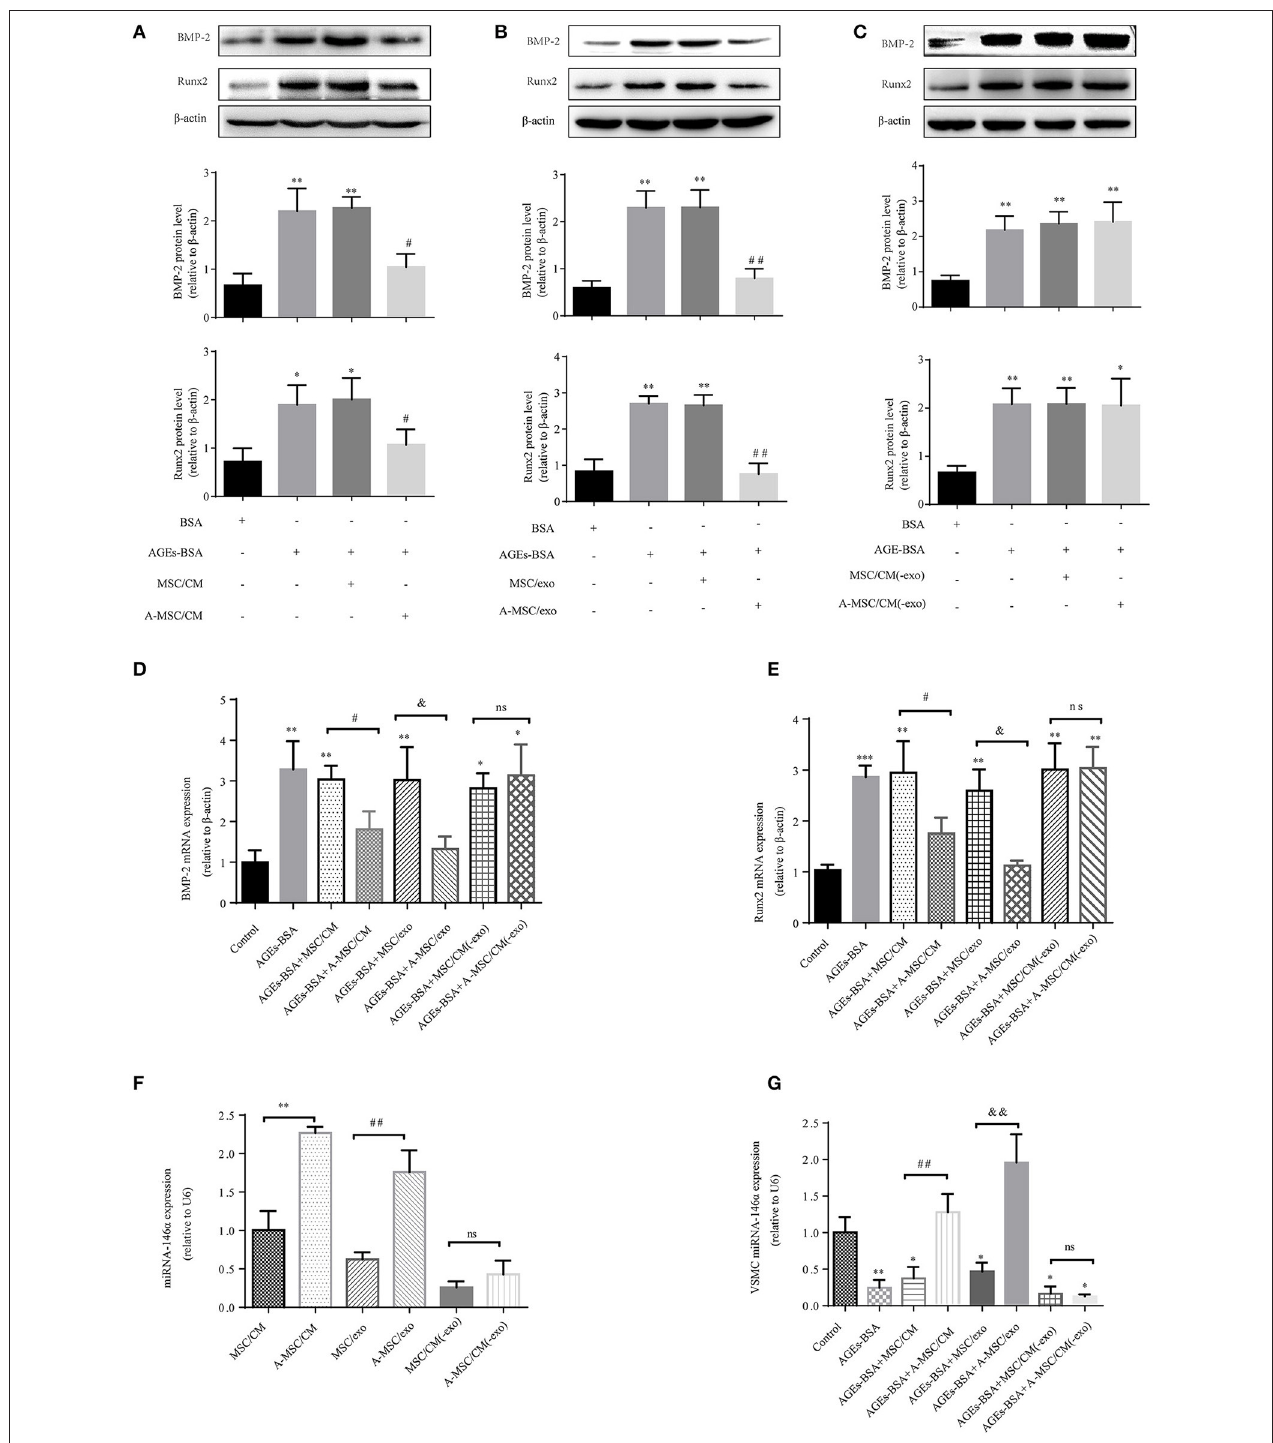
FIGURE 5 | MSCs pretreated with AGEs-BSA transfer miR-146a in exosomes to inhibit osteogenic differentiation of VSMC. VSMCs were cultured in 200 µ g/mL BSA, AGEs-BSA, AGEs-BSA + MSC/CM, AGEs-BSA + A-MSC/CM, AGEs-BSA + MSC/exo, AGEs-BSA + A-MSC/exo, AGEs-BSA + MSC/CM(-exo), or AGEs-BSA + A-MSC/CM(-exo). (A–C) Runx2 and BMP-2 protein levels determined by Western blotting. (D,E) Runx2 and BMP-2 mRNA levels were determined by qPCR. * p < 0.05, ** p < 0.01, and *** p < 0.001 vs. the control group (200 µ g/mL BSA); # p < 0.05 AGEs-BSA + MSC/CM vs. AGEs-BSA + A-MSC/CM; & p < 0.05 AGEs-BSA + MSC/exo vs. AGEs-BSA + A-MSC/exo; ns p > 0.05 AGEs-BSA + MSC/CM(-exo) vs. AGEs-BSA + A-MSC/CM(-exo). (F) miR-146a level determined by qPCR. ** p < 0.01 MSC/CM vs. A-MSC/CM; ## p < 0.01 MSC/exo vs. A-MSC/exo; and ns p > 0.05 MSC/CM(-exo) vs. A-MSC/CM(-exo). (G) miR-146a level in VSMCs determined by RT-qPCR. * p < 0.05 and ** p < 0.01 vs. the control group (200 µ g/mL BSA); ## p < 0.01 AGEs-BSA + MSC/CM vs. AGEs-BSA + A-MSC/CM; && p < 0.01 AGEs-BSA + MSC/exo vs. AGEs-BSA + A-MSC/exo; and ns p > 0.05 AGEs-BSA + MSC/CM(-exo) vs. AGEs-BSA + A-MSC/CM(-exo).